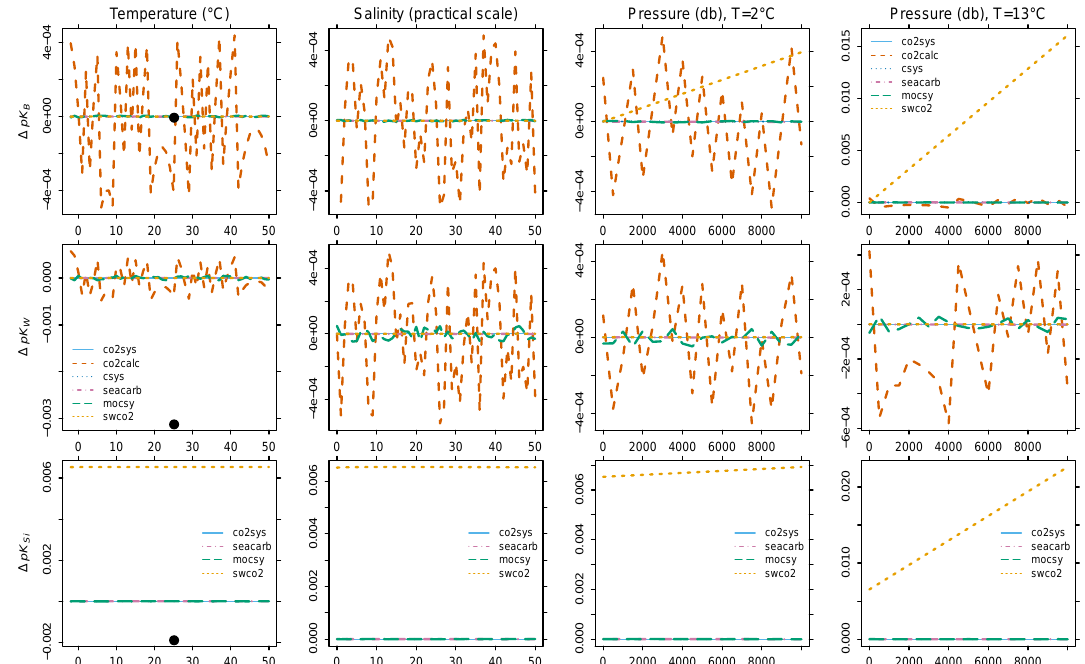
Figure 17. The p K B (top), p K W (middle), and p K Si (bottom) computed from each package minus corresponding values from CO2SYS- MATLAB. Formulations are from Millero (1995), as recommended for best practices. The filled black circles indicate the check values (Table